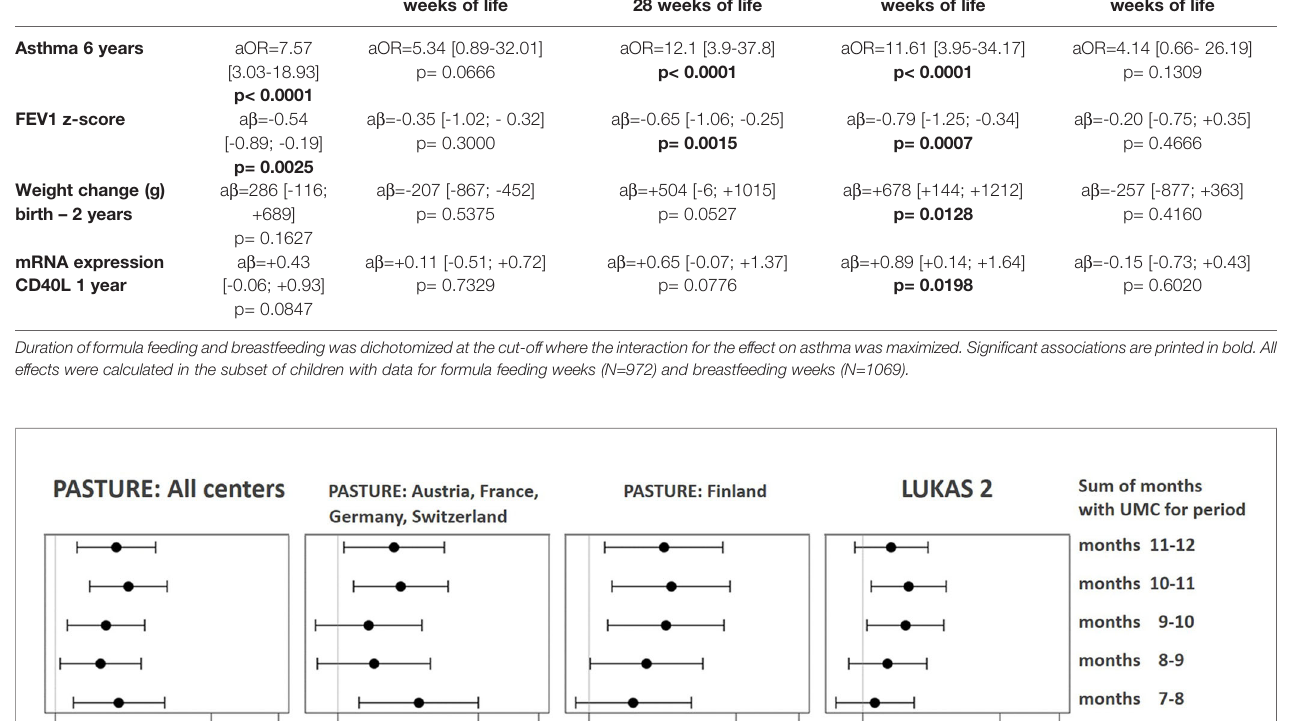
TABLE 2 | Effects of UMC strati fi ed by duration of formula feeding and breastfeeding. All children Formula feeding up to 28 Formula feeding more than weeks of life 28 weeks of life